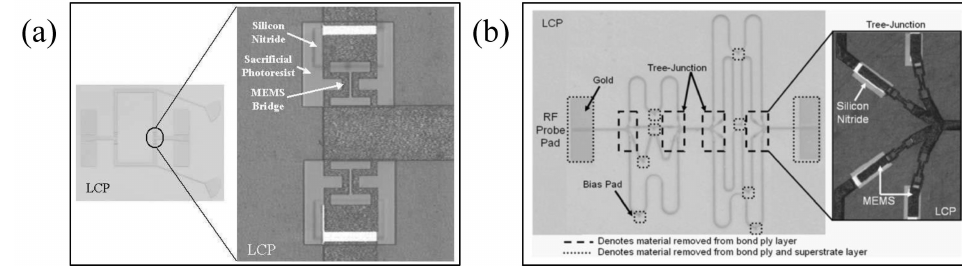
Figure 4. ( a ) Fabricated MEMS switch and phase shifter based on LCP substrate used in the packaging process [77] Reprinted/adapted with permission from Ref. [77]. 2005, IEEE. ( b ) Miniaturized, low- loss 4-bit flexible RF MEMS phase shifter [78] Reprinted/adapted with permission from Ref. [78]. 2006,